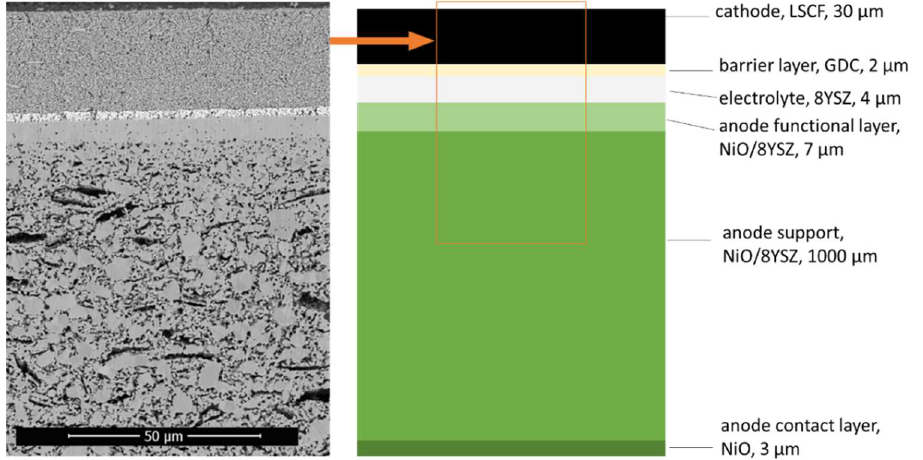
Figure 1. The structure of the anode-supported SOFC used in the experimental campaign.